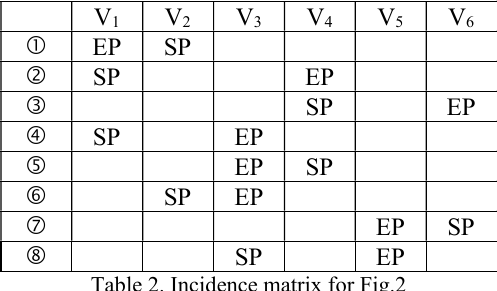
Table 2. Incidence matrix for Fig.2